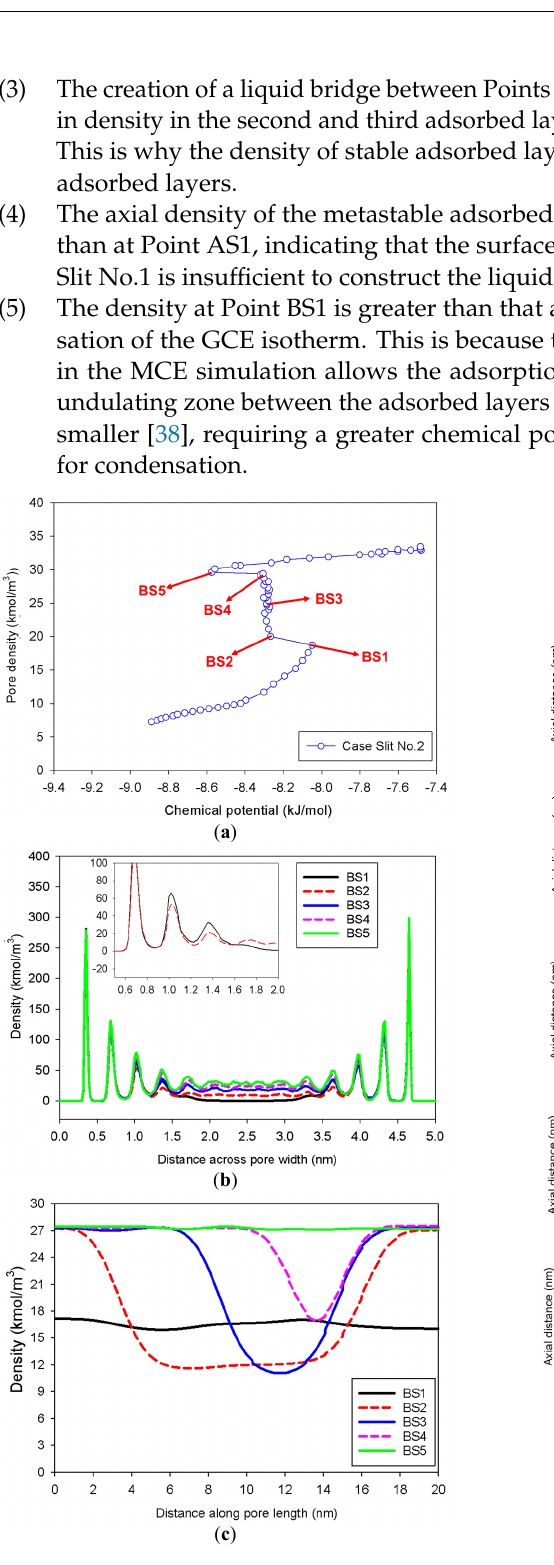
Figure 6. ( a ) Nitrogen adsorption isotherm in the infinite slit pore of 5 nm width at 77 K for Slit No.2, its local density distributions ( b ) across pore width and ( c ) along pore length, and ( d ) molecular snapshots of nitrogen on each point.